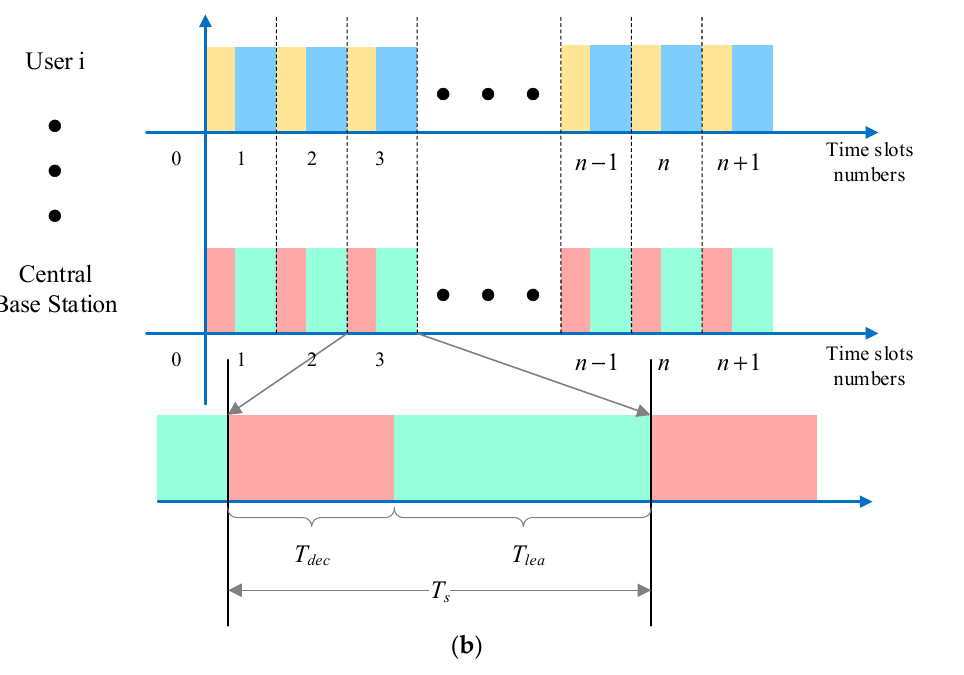
Figure 2. Schematic diagram of time slot structure: ( a ) schematic diagram of user time slot structure in the system; ( b ) schematic diagram of central base station time slot structure.